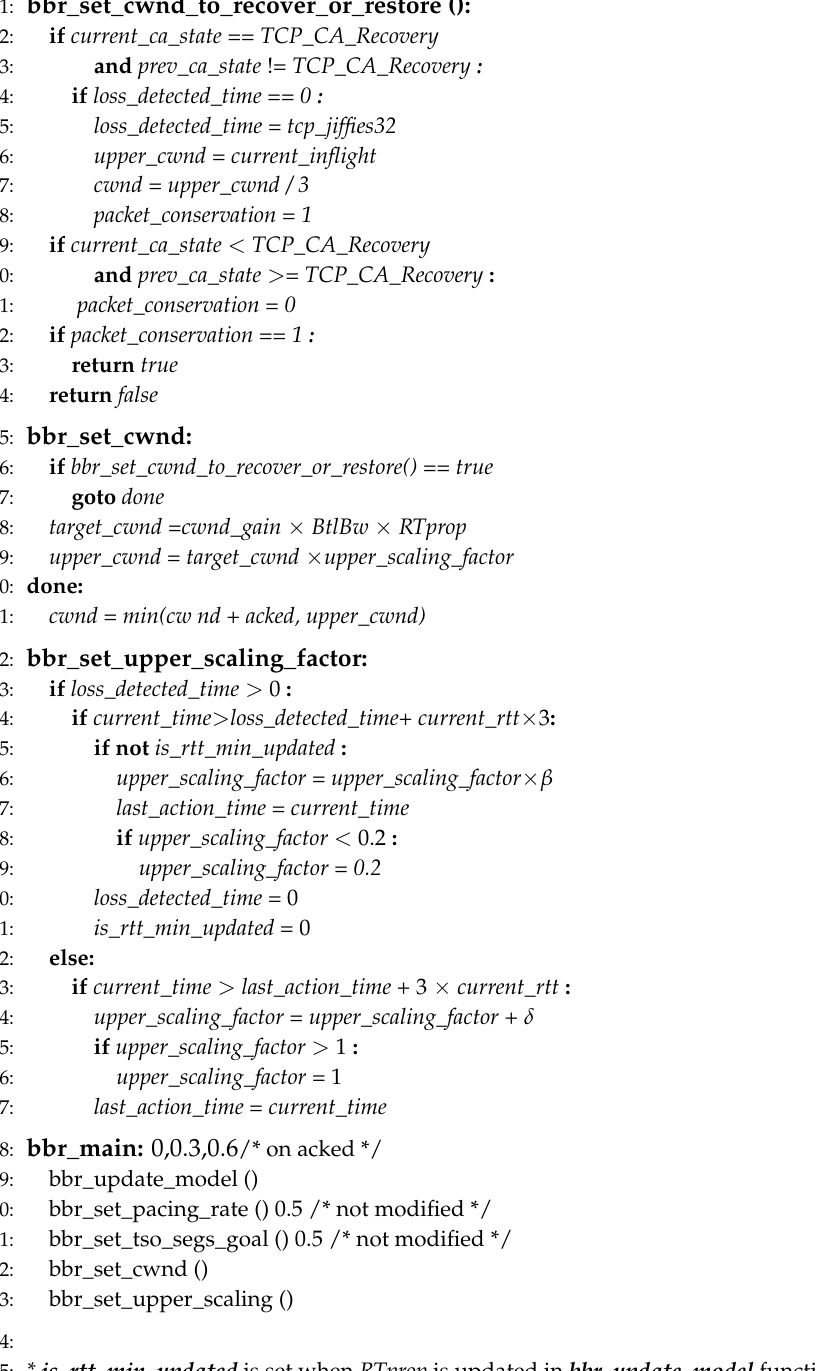
Algorithm 1 BBR congestion window upper